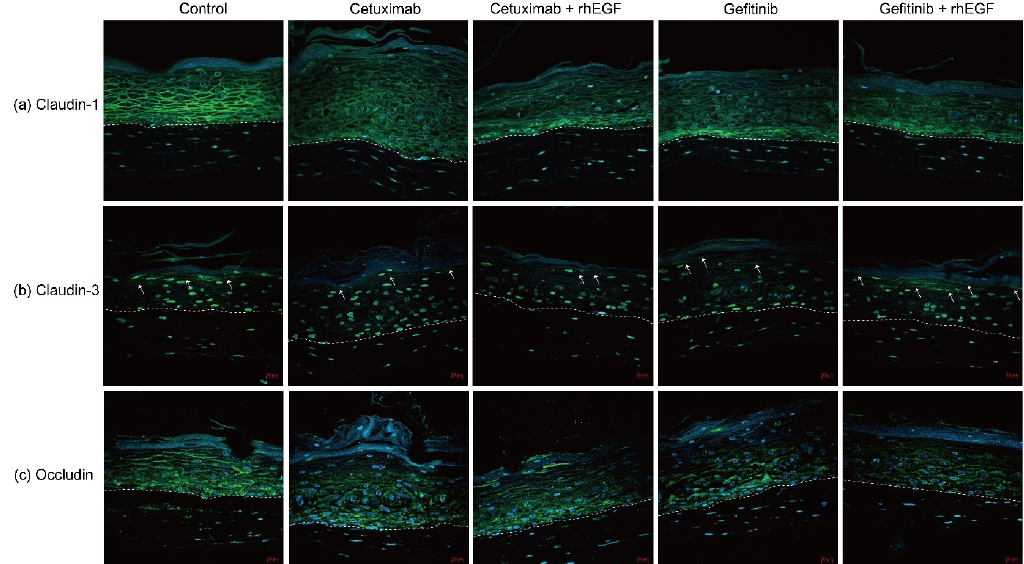
Figure 3. Tight junction expression was erupted by EGFRIs, which was weekly normalized by rhEGF. Claudin-1 expression was seen in epidermal layers, especially the suprabasal layer ( a ). Expression of claudin-3 in stratum corneum and stratum granulosum junction ( b ). Expression of occludin was observed in all epidermal layers ( c ). (Magification, ×20, Scale bar: 20 μ M)